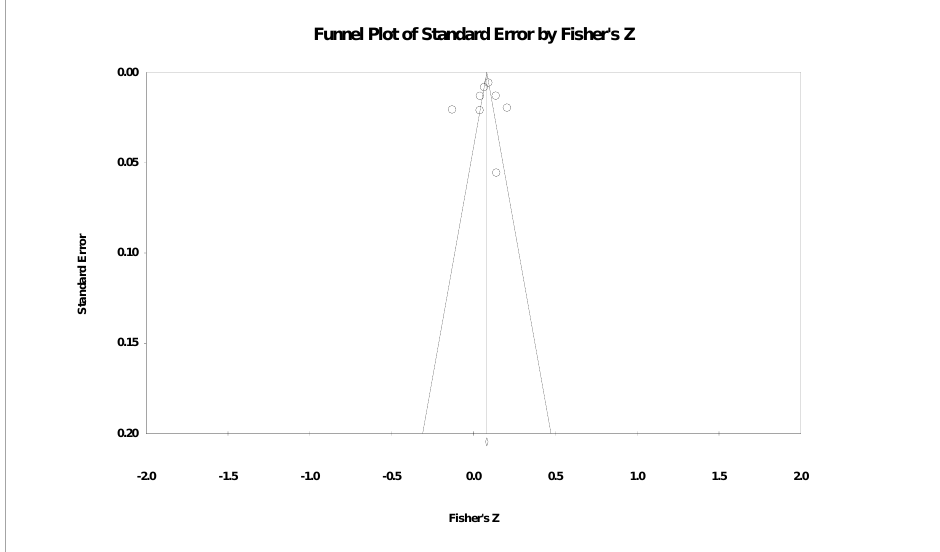
Figure 4. Funnel plot of the association between AFEs and physical well-being.